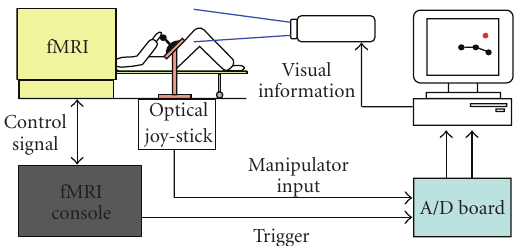
Figure 3: Experimental